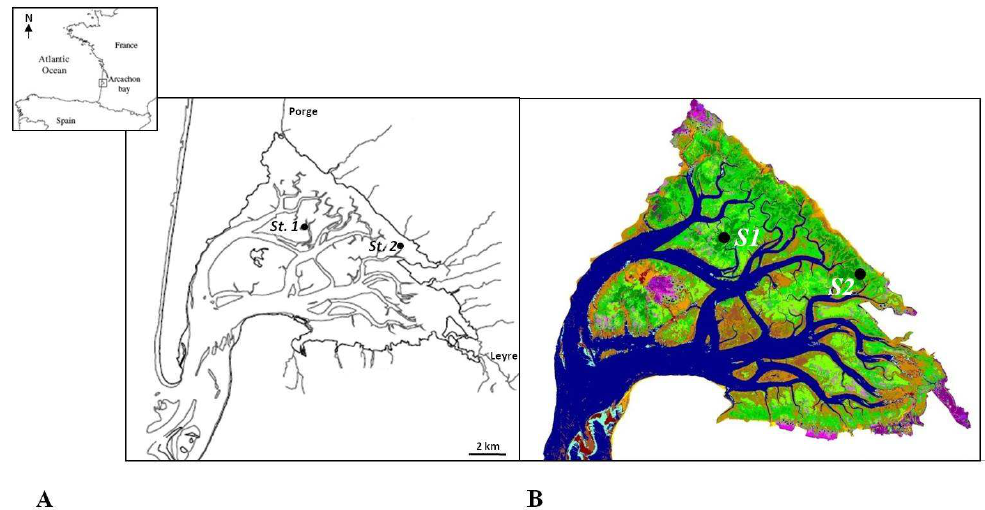
Fig. 1. Localisation of the Eddy Covariance (EC) experimental sites. (A) The Arcachon flat with the subtidal zone (channels) and the intertidal mudflat area; (B) the two EC sites: Station 1 (44 ◦ 42 0 59.15 00 N, 01 ◦ 08 0 36.96 00 W) and Station 2 (44 ◦ 42 0 19.96 00 N, 01 ◦ 04 0 01.35 00 W). The Zostera noltii seagrass meadow is derived from the SPOT satellite image of the 22 June 2005; it represents 60% of the intertidal area (shades of green show the differences in seagrass